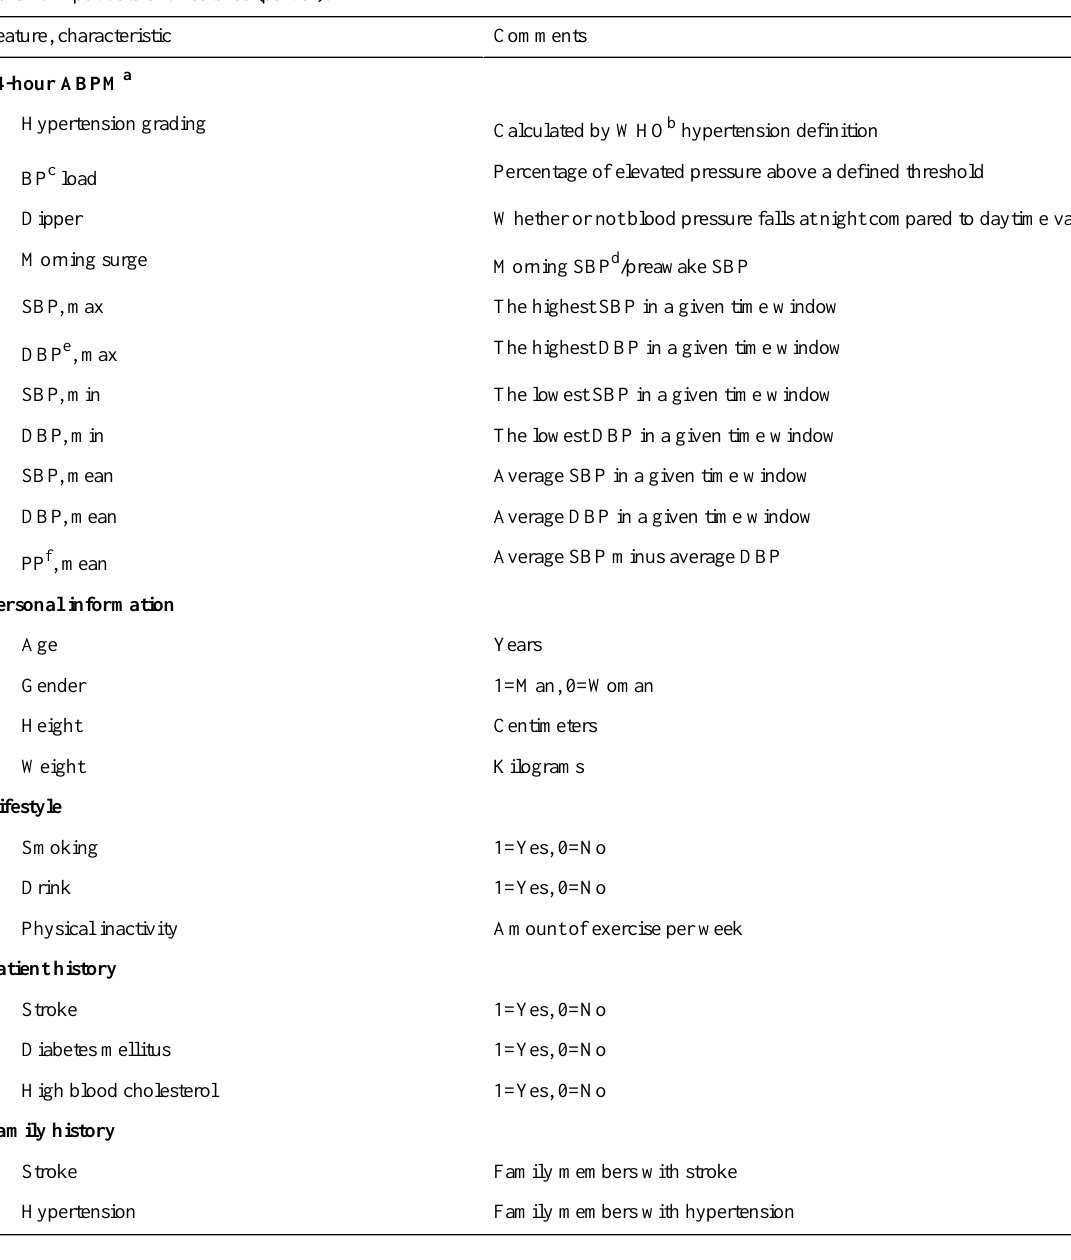
Table 1. Input data and features